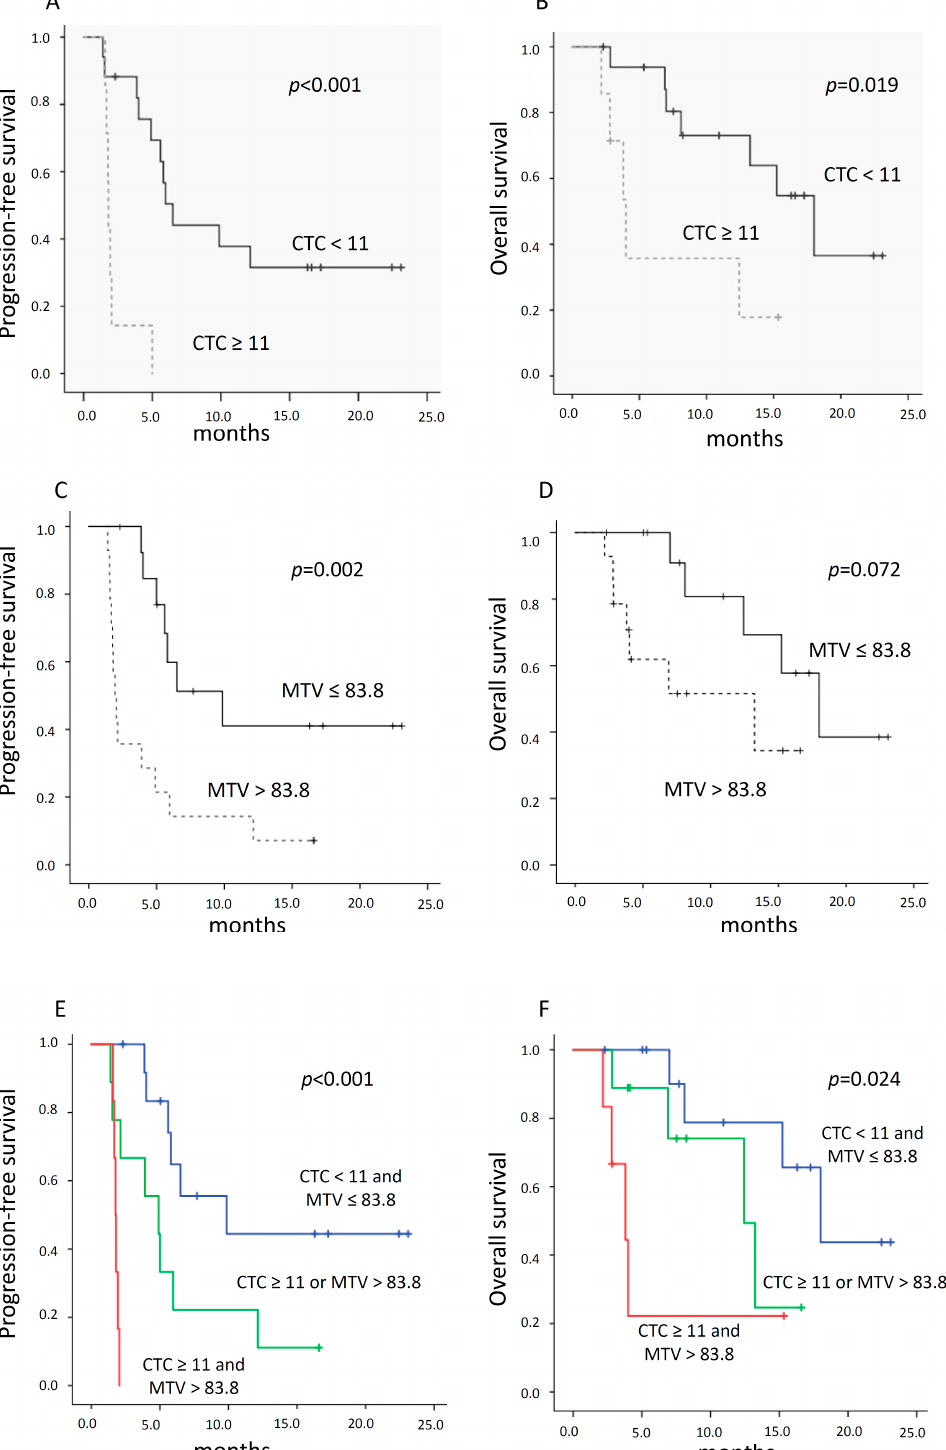
Figure2. Kaplan–MeiercurvesaccordingtoCTCcountandmetabolicparameters. ( A , B )Progression-free survival (PFS) and overall survival (OS) according to CTC count at 8 weeks, below or above the mean value. ( C , D ) PFS and OS of patients with MTV at 8 weeks greater or lower than median value. ( E , F ) PFS and OS according to the combination of mean number of CTC and median MTV after 8 weeks of